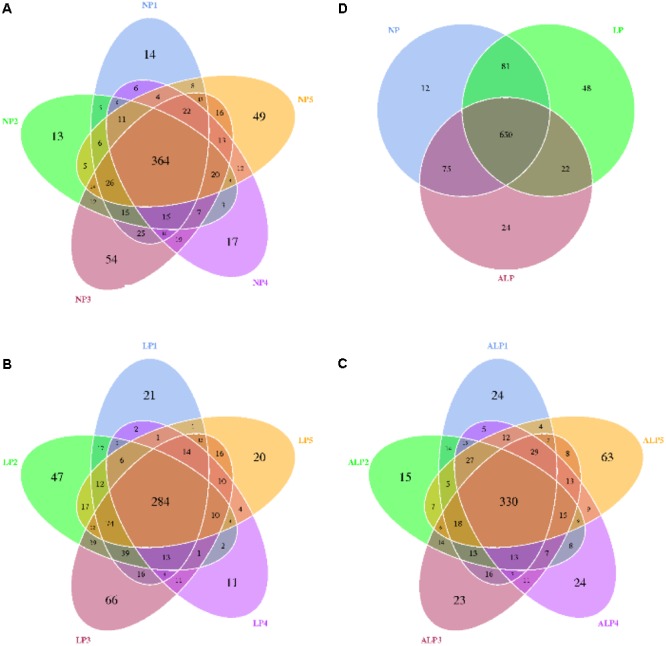
Shared OTUs analysis of the different samples. Venn diagram showing the unique and shared OTUs in the different samples. NP, LP, and ALP are samples mentioned in Supplementary Table S1. (A) for NP1, NP 2, NP 3, NP 4, and NP 5 samples; (B) for LP1, LP 2, LP 3, LP 4, and LP 5 samples; (C) for ALP1, ALP 2, ALP 3, ALP 4, and ALP 5 samples; (D) for NP, LP, and ALP samples; NP, normal protein; LP, low protein; ALP, AKG plus low protein.